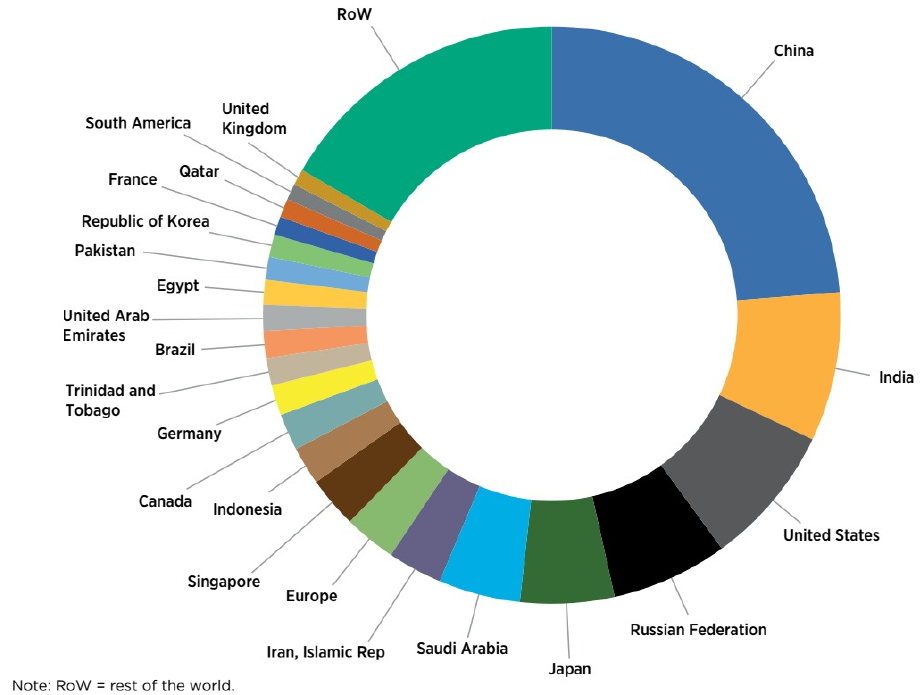
Figure 23. Hydrogen demand by country in